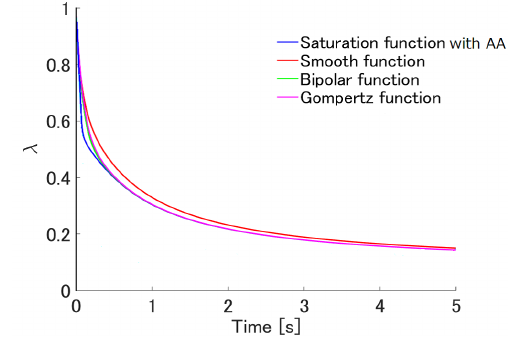
Figure 19. Time response of slip ratio on icy road